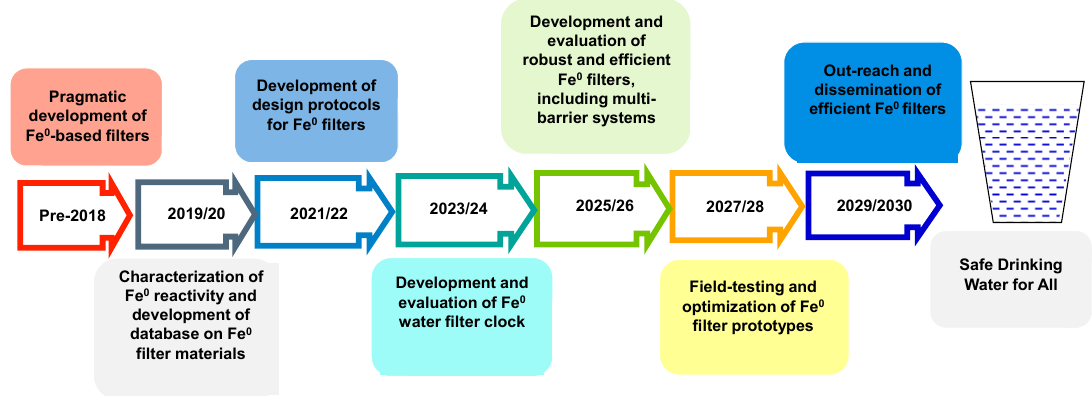
Figure 4. A proposed framework for advancing research on Fe 0 /H 2 O filters in the next decade up to 2030.